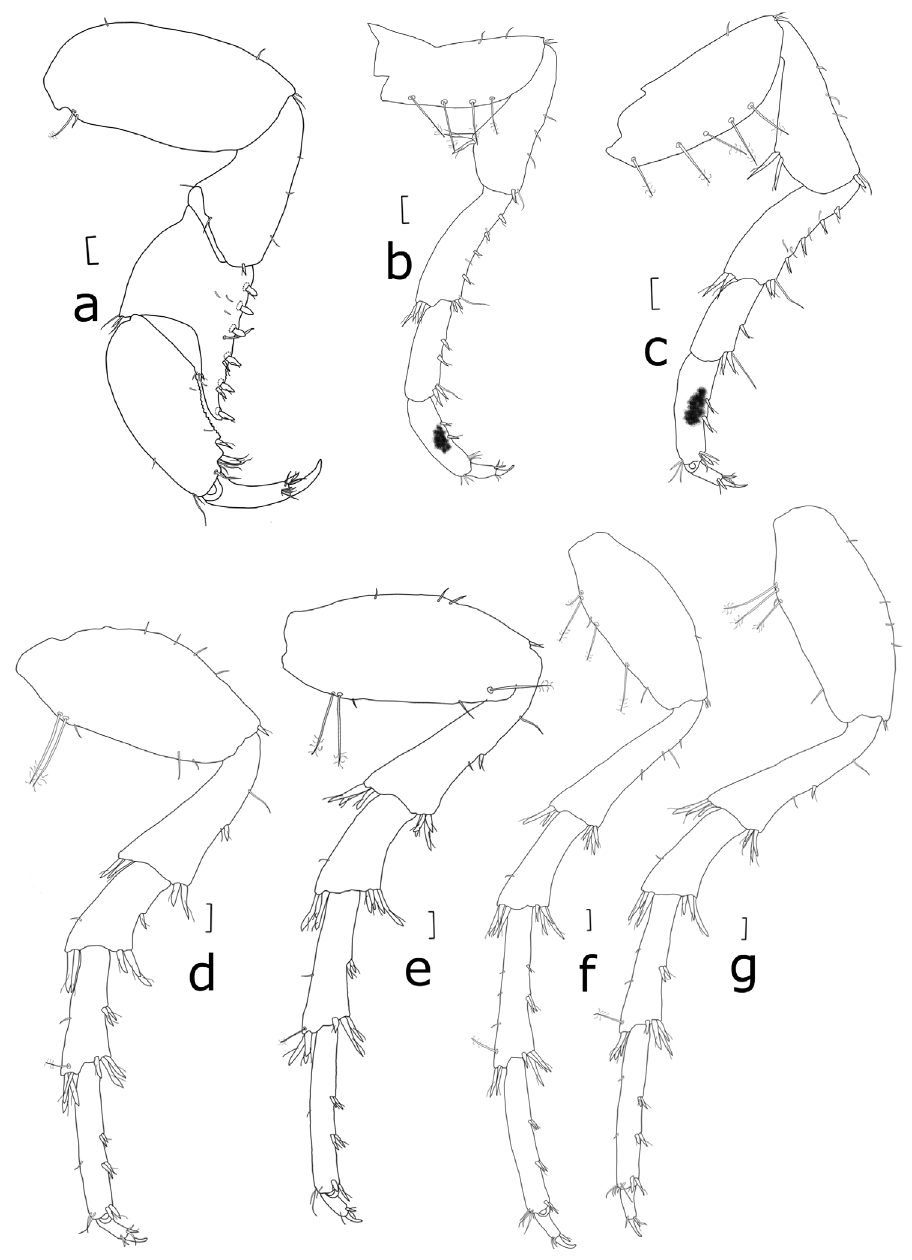
Figure 4. Typhlocirolana longimera sp. n. a–g pereopods 1–7. Scale: a–g = 0.1